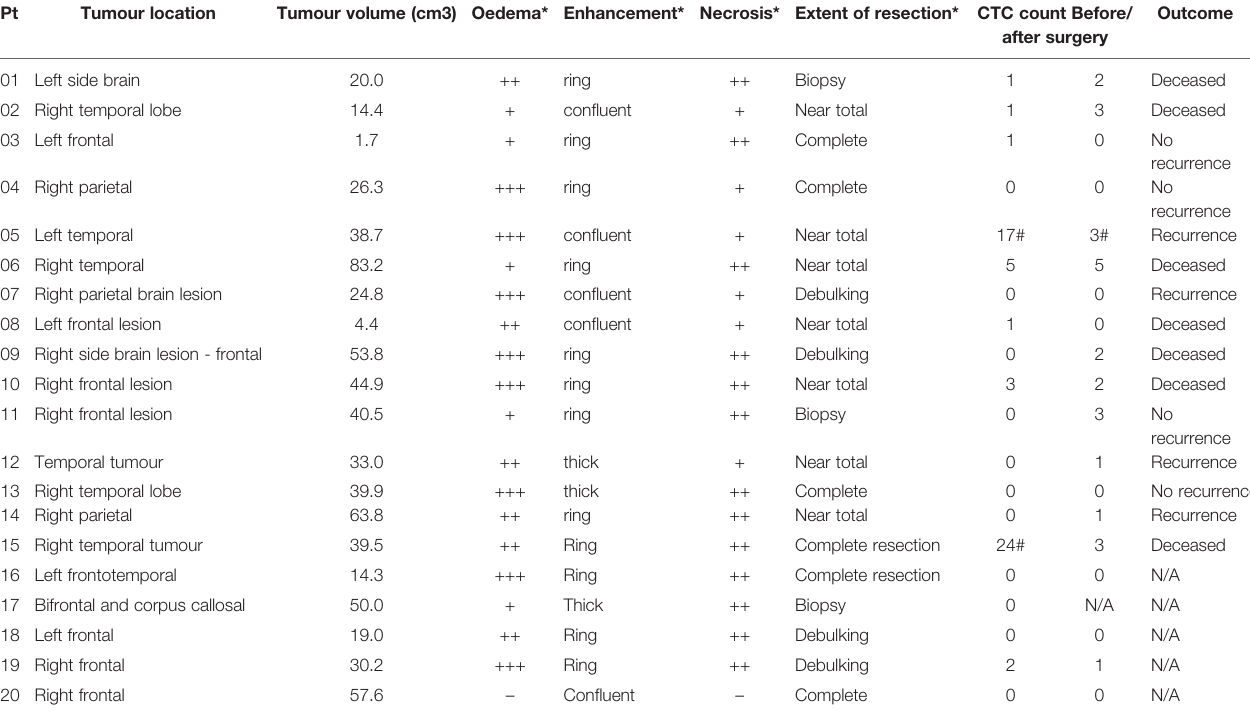
TABLE 2 | CTCs counts and clinical data from GBM patients.